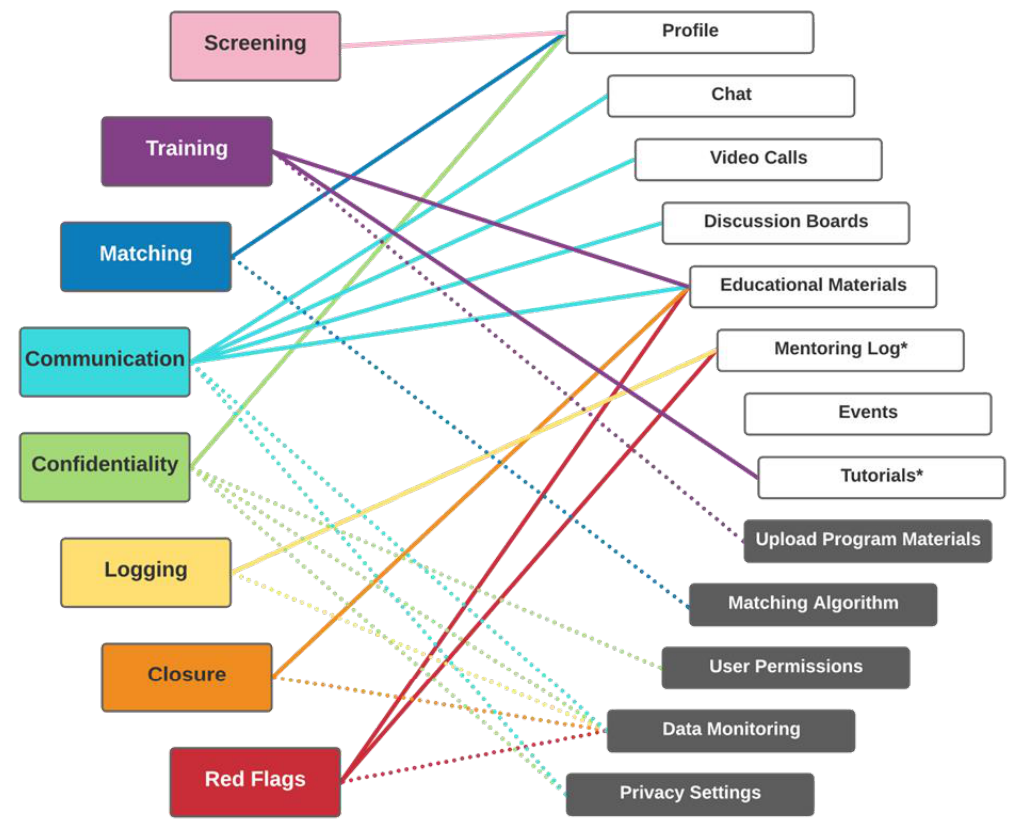
Figure 2. Mapping of key peer mentoring program components to platform features. Key components of peer mentoring programs (colored boxes) are supported by app features (white boxes, solid lines) and administrator portal functions (gray boxes, dotted lines). * Features not native to the app, but that were able to be addressed by linking to external resources, such as materials or surveys.